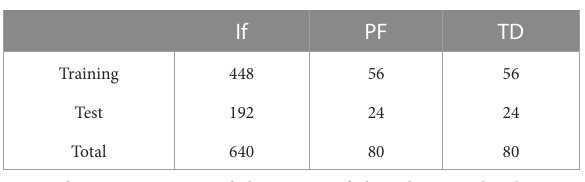
TABLE1 Eventnumberdistributionofeachdataset.